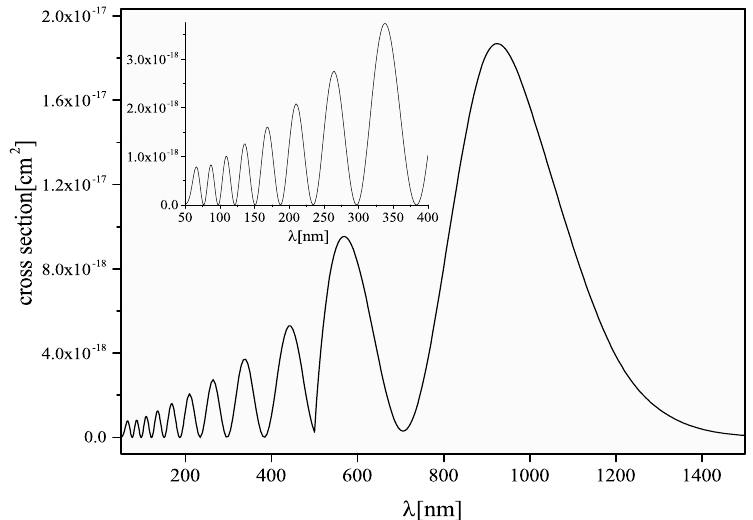
Figure 6. The behavior of the cross-section σ J , v ( λ ) Equation (4) for J = 0 and v = 10, as a function of λ (see